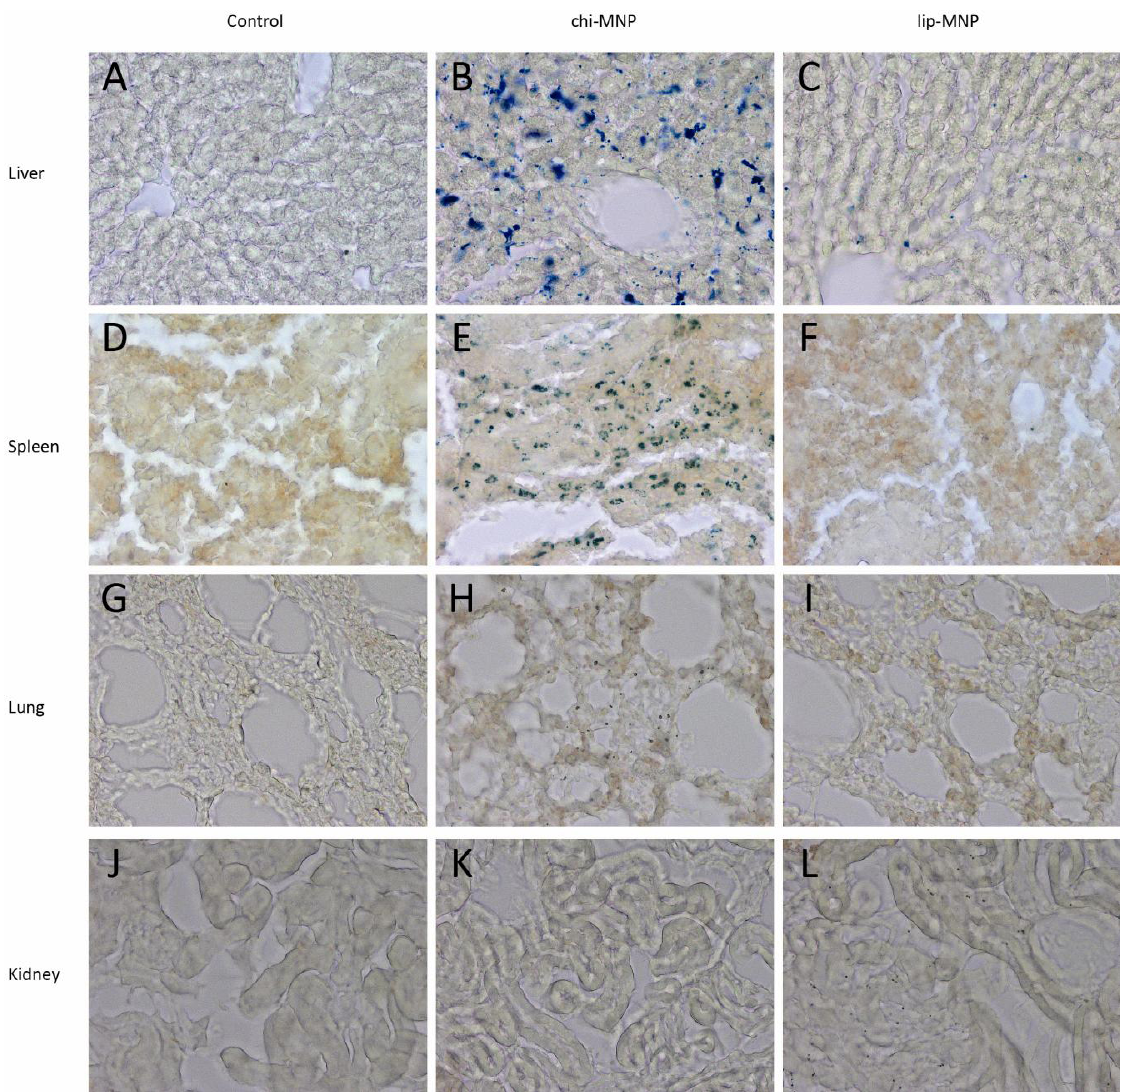
Figure 5. Representative images of columns are divided into three groups: non-injected controls, chi-MNP and lip-MNP. Rows are divided into organ-type: liver, spleen, lung and kidney. The control liver ( A ) was negative for non-heme iron whereas the chi-MNP liver was extensively positive for iron ( B ), which was displayed by an intense uneven blue colorization of the entire liver. Lip-MNP liver ( C ) showed only minute amounts of iron. The control spleen ( D ) as well as the lip-MNP spleen ( E ) was negative for the presence of iron whereas a strong positive reaction for iron was seen in the chi-MNP spleen ( F ). The control lung ( G ) was negative for non-heme iron. This was contrasted by the chi-MNP lung ( H ), which showed diffuse iron staining of the alveoli septa. Lip-MNP lung ( I ) did not show any reaction for iron. The control kidney ( J ) as well as the chi-MNP kidney ( K ) was negative for non-heme iron. Interestingly the lip-MNP kidney ( L ) showed a diffuse distribution of particulate shaped iron. Magnification: